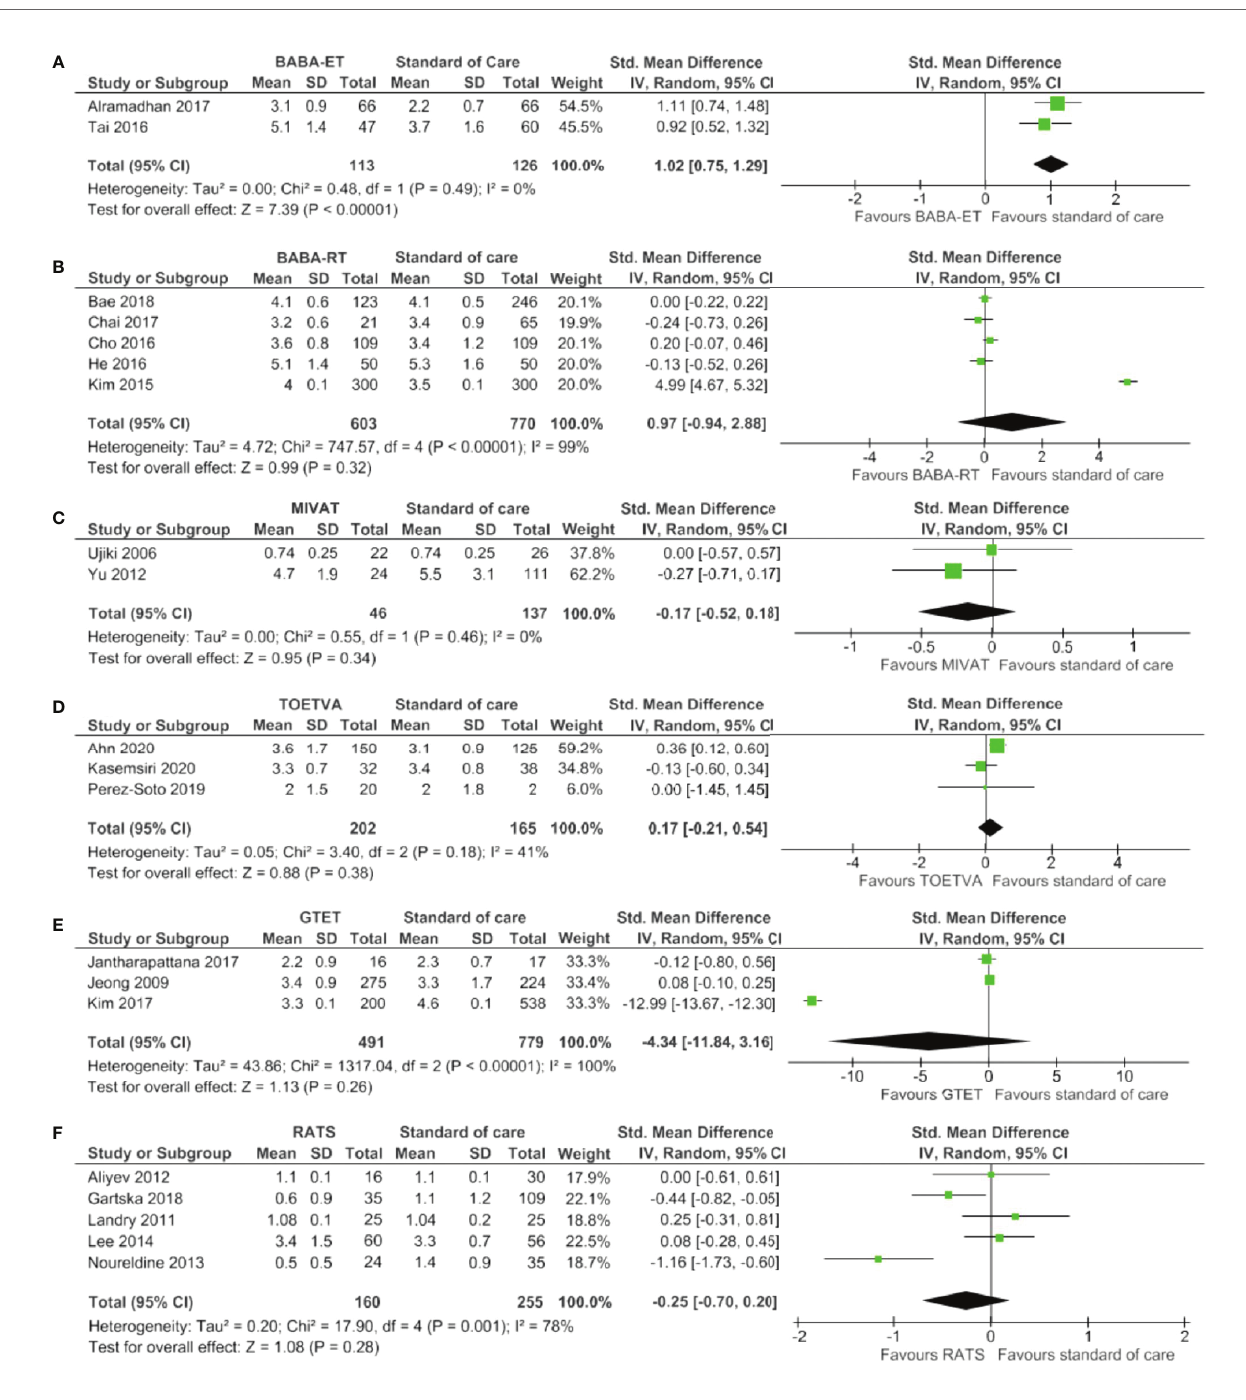
FIGURE 4 | Forests plots of hospital stay for (A) BABA-ET, (B) BABA-RT, (C) MIVAT, (D) TOETVA, (E) GTET and (F)